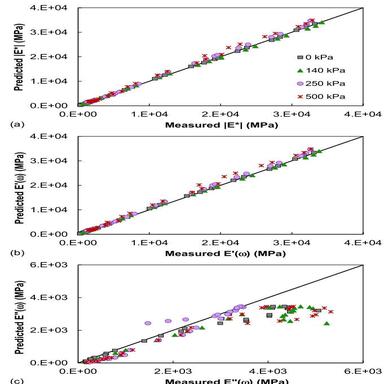
Comparison of the measured and predicted moduli in the arithmetic scale (Mix B): a) dynamic modulus, b) storage modulus, and c) loss modulus.